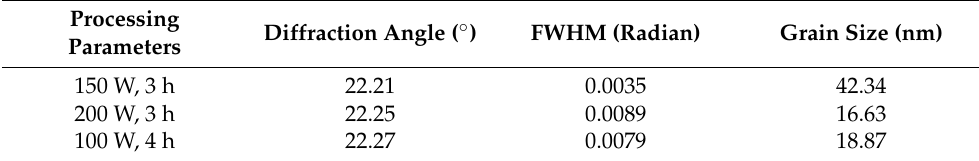
Table 2. The grain size of Fe in the TbDyFe films calculated from the diffraction angle and FWHM.